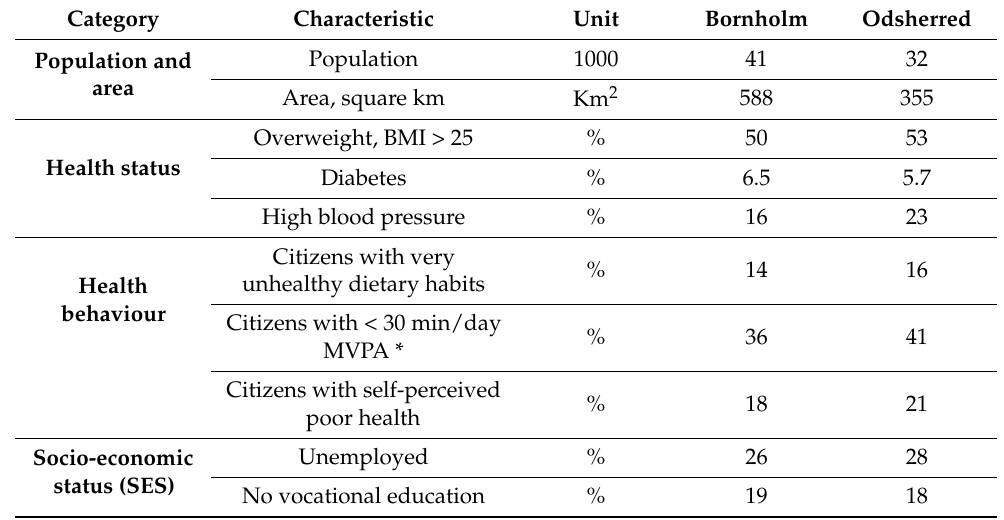
Table 1. Characteristics of the populations (>16 years) in Bornholm and Odsherred municipalities.